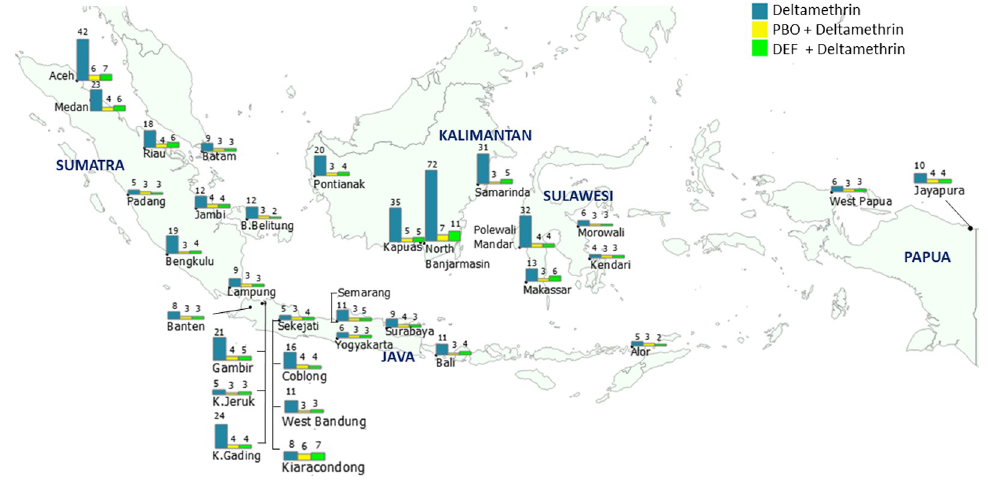
Fig 3. Map of RR 50 of Ae . aegypti field strains to deltamethrin without and with synergists. Map base layer was obtained from https://www.naturalearthdata.com/. Map base layer was modified in QGIS software version 3.4 Madeira. Note: The number above each bar represents RR 50 , which was calculated relative to the susceptible reference strain (Bora- Bora).